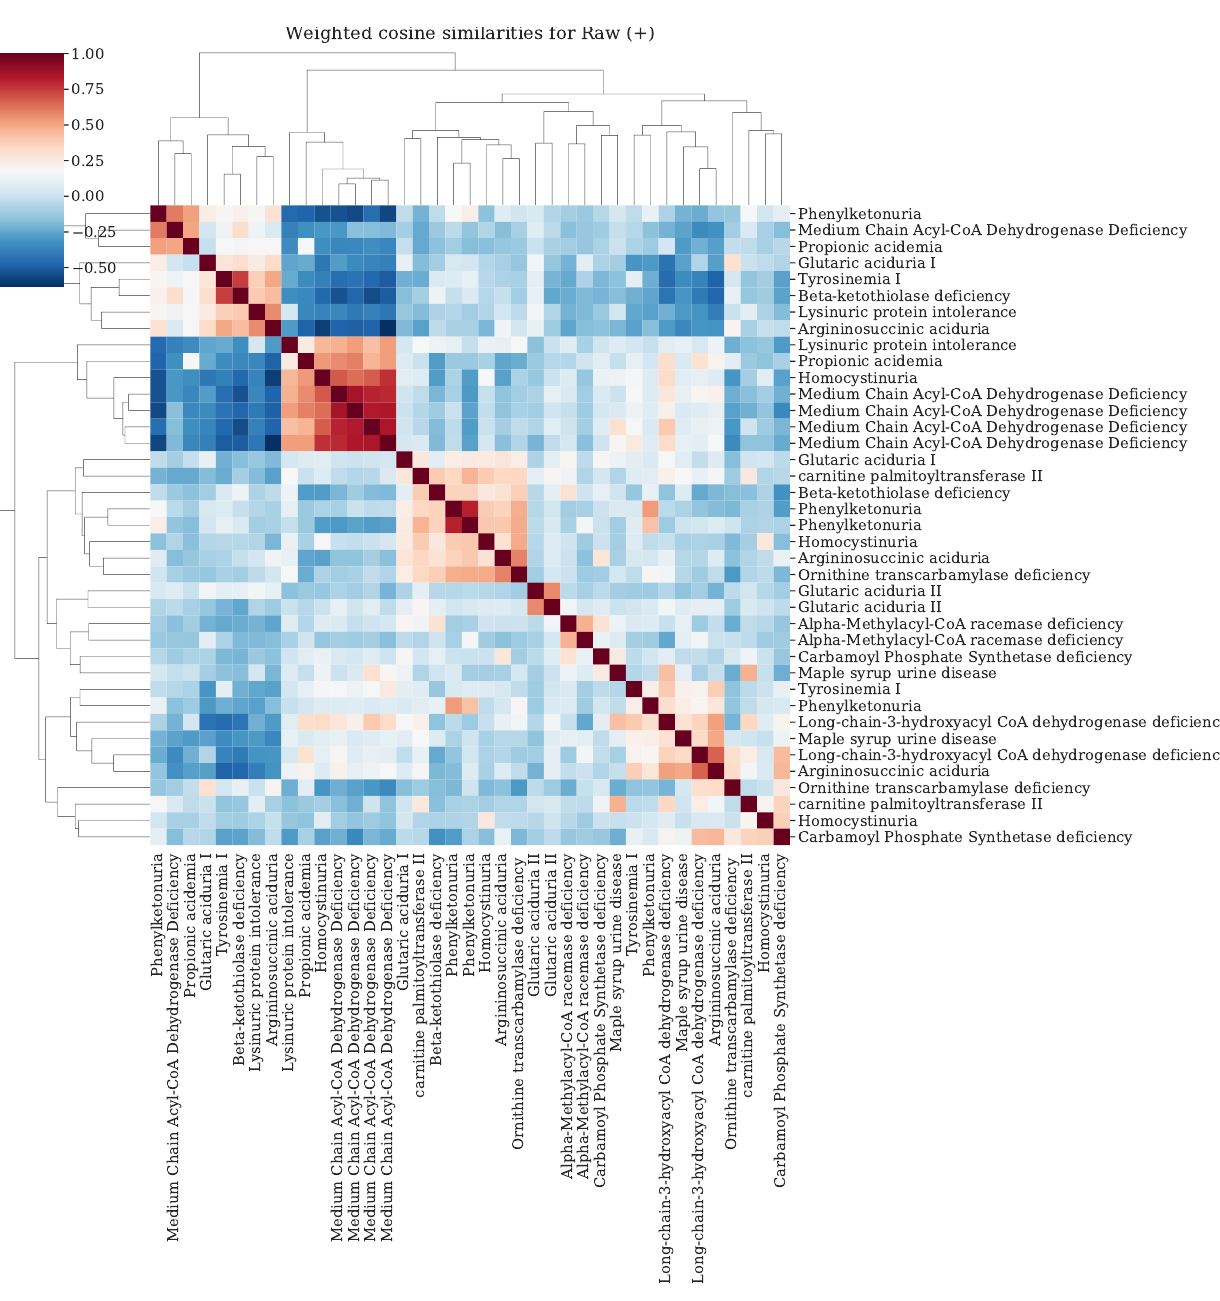
Figure A10. Clustermap of the weighted cosine similarities for IEM patients in positive ion mode using Raw